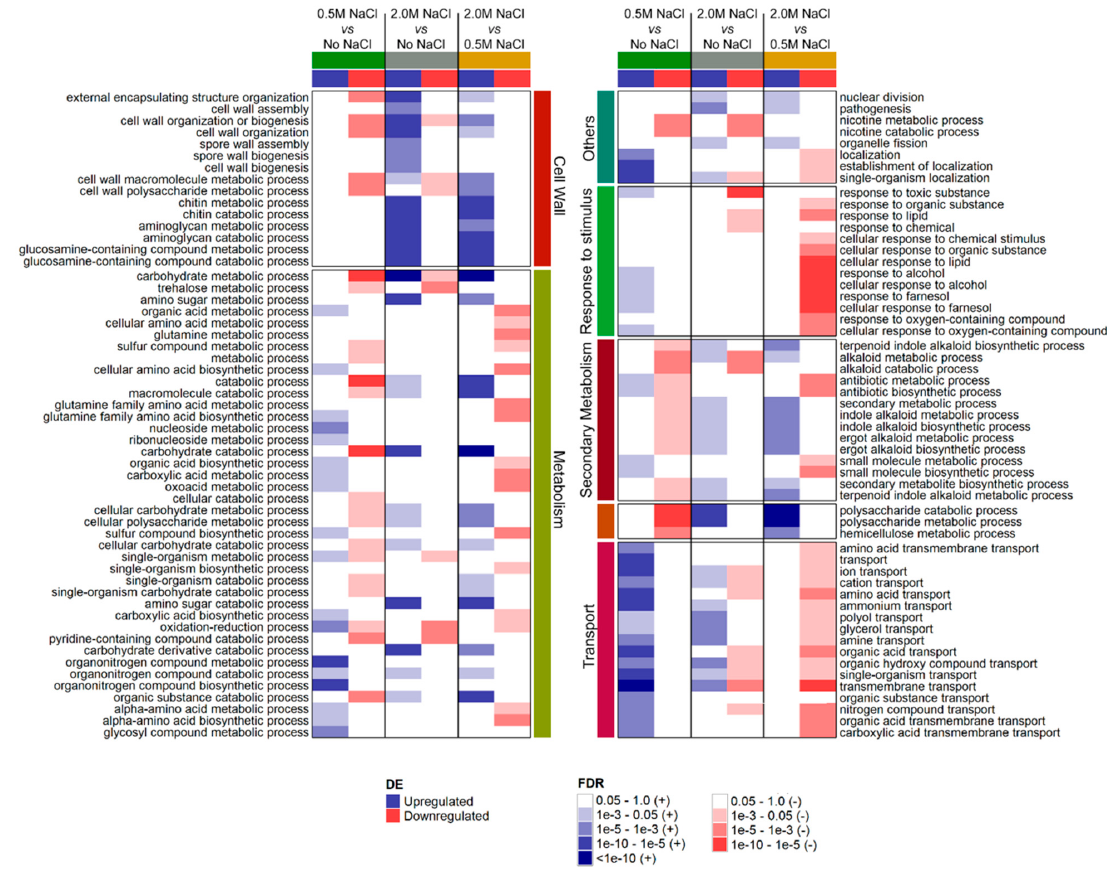
Figure 3. GO enrichment in the sets of differentially expressed (DE) transcripts for each evaluated comparison. False discovery rate (FDR) for the enrichment of each GO term was obtained by over- representation